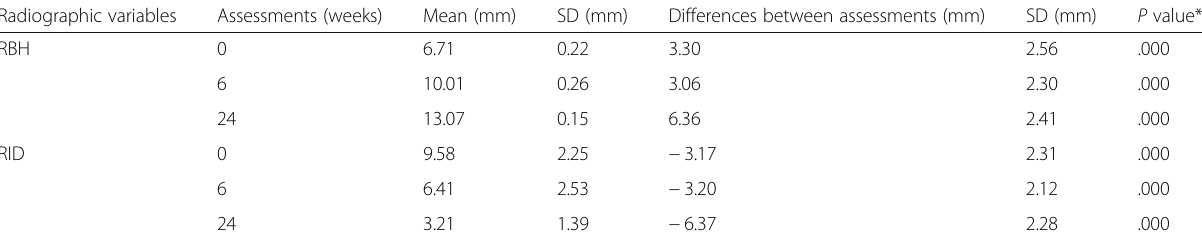
Table 3 Average changes in RBH and RID over time ( n = 34) Radiographic